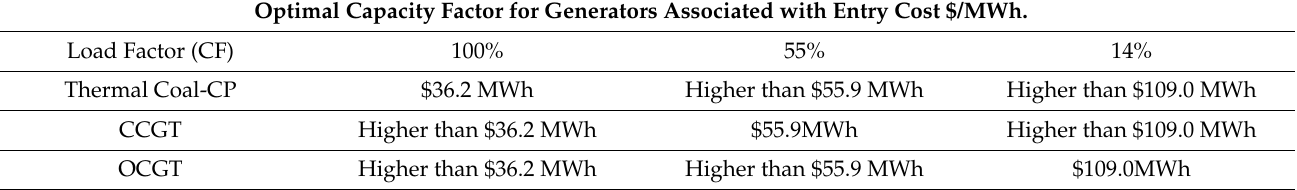
Table 6. Load Capacity Factor for Coal & Gas Generators Vs. Cost $/MWh. Optimal Capacity Factor for Generators Associated with Entry Cost